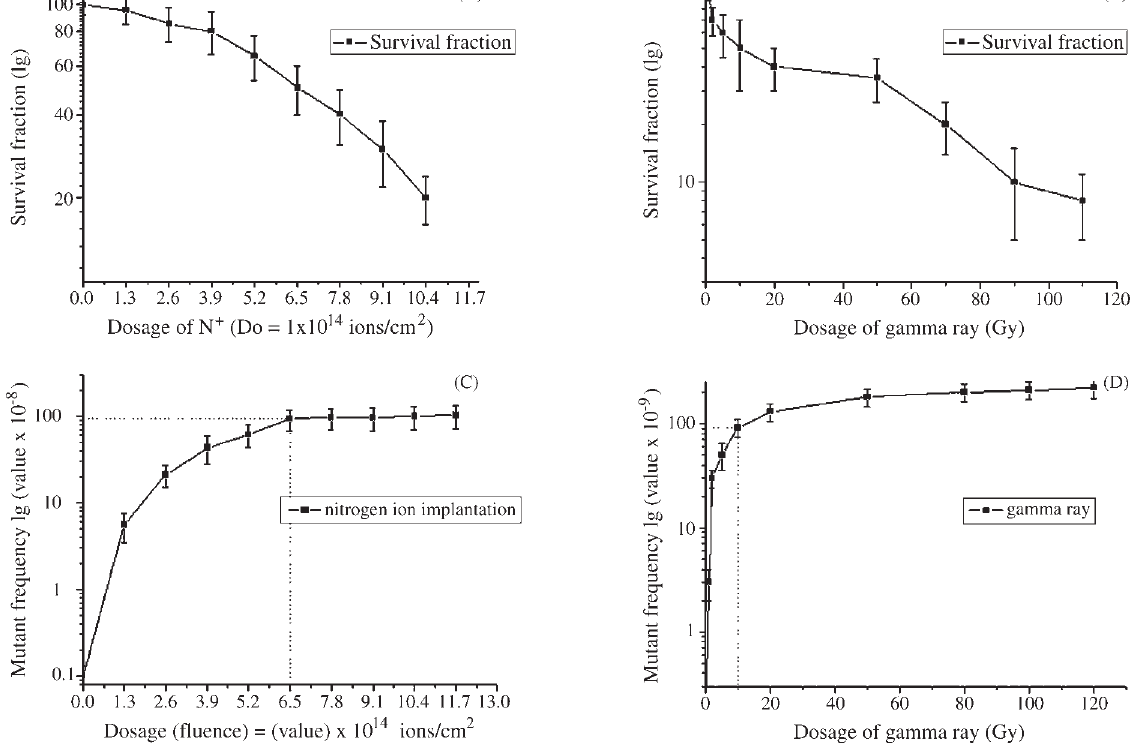
Figure 1 - Cytotoxicity (A, B) and mutagenicity (C, D) induced by low-energy nitrogen ion beam implantation and 60 Co-gamma rays.